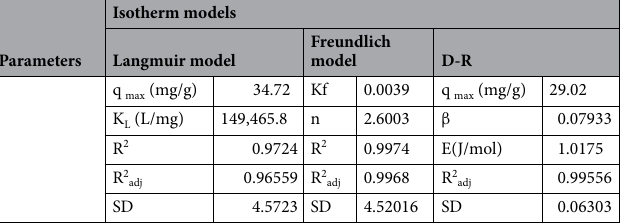
Table 2. Comparison of isotherm parameters of dye adsorption onto GO- Ziziphus .